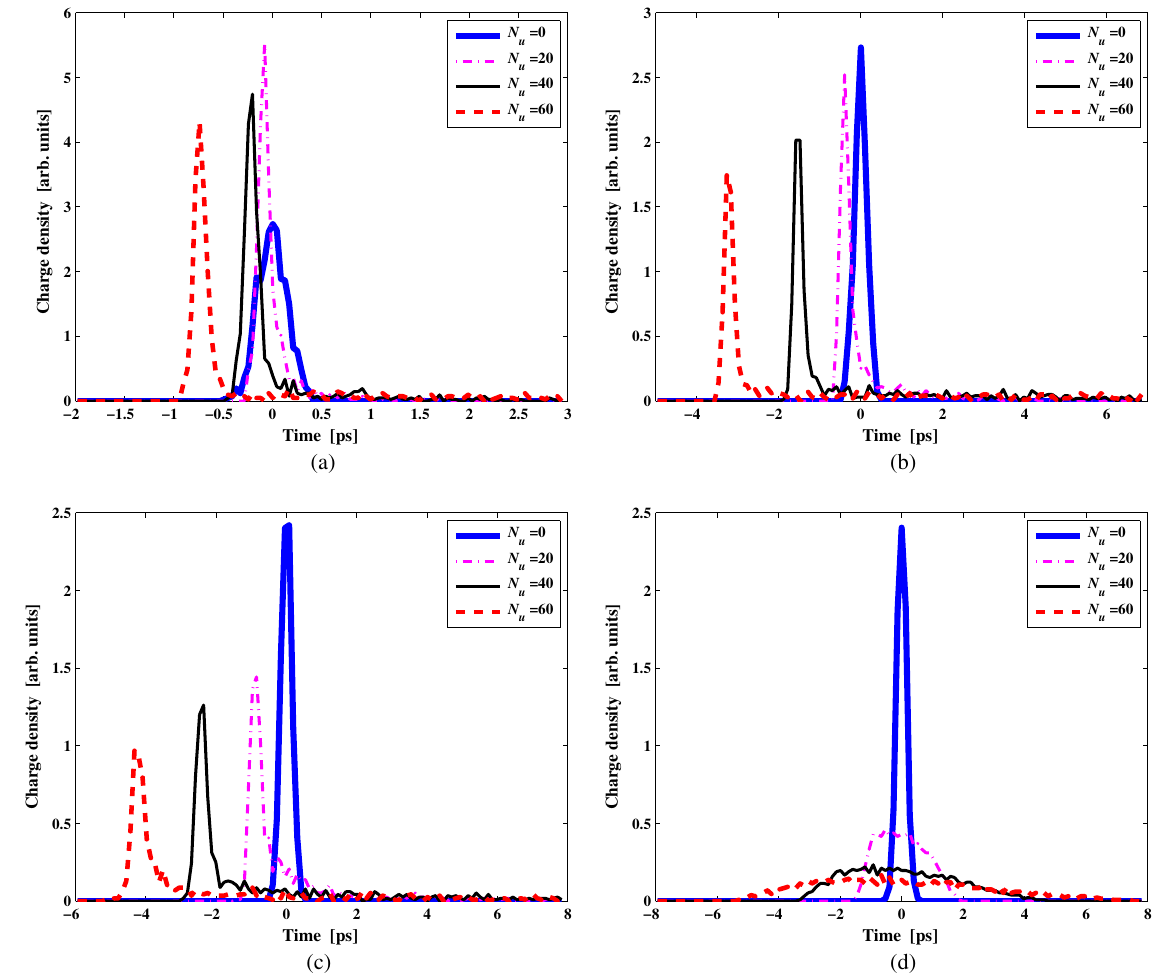
FIG. 2. Bunch density at the undulator entrance and after each 50 periods along the beam line: charges 0.5 nC (a), 1.5 nC (b), and 2.5 nC (c) for the positive guiding magnetic field, and 0.5 nC for the “ negative ” field (d). The time is given in the pictures relative to the “ center of mass ” of the bunch; presence of a bunch tail shifts the dominant peak of the bunch distribution out of the